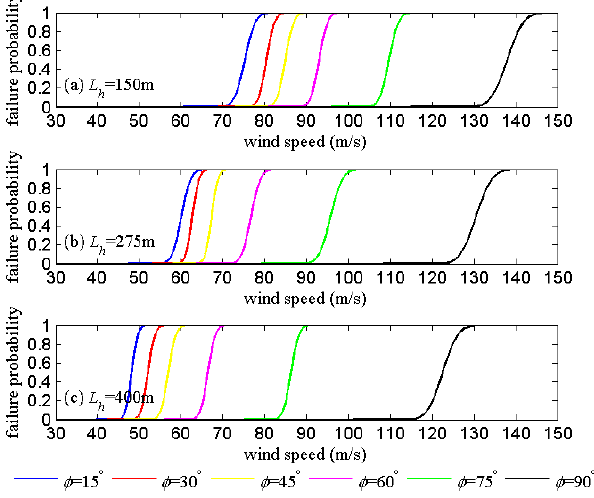
Figure 11. Structural fragility curves of tower ZY. ( a ) L h = 150 m; ( b ) L h = 275 m; ( c ) L h = 400 m. Taking the practical transmission line (Table 1) as the example and considering the normal segment of the line (i.e., the blue section in Figure 12), we conducted the structural fragility assessment on the towers and the line segment under typhoons by implementing the workflow of the fragility calculation, shown in Figure 10.